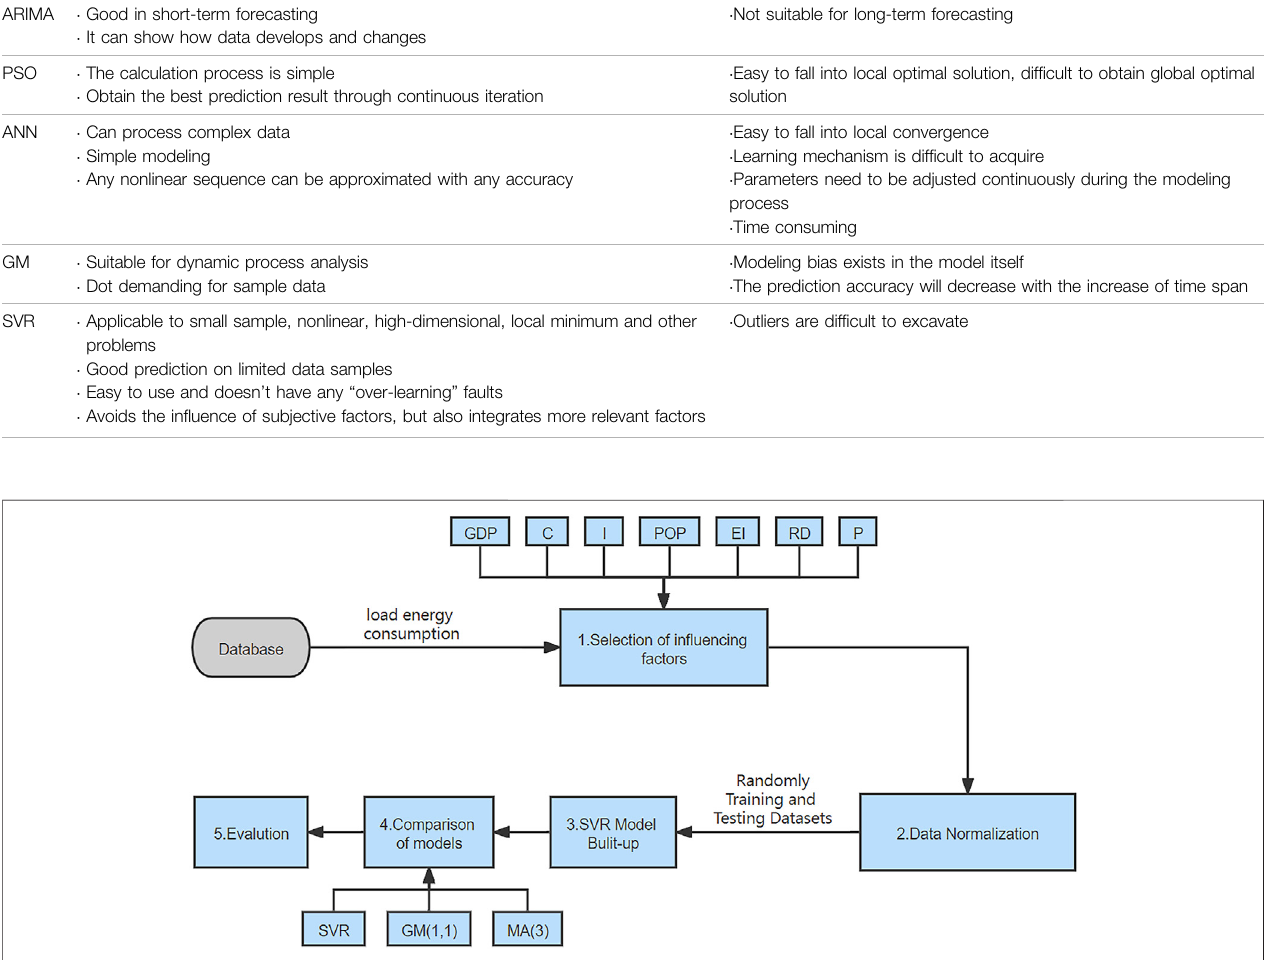
FIGURE 4 | Framework of energy consumption